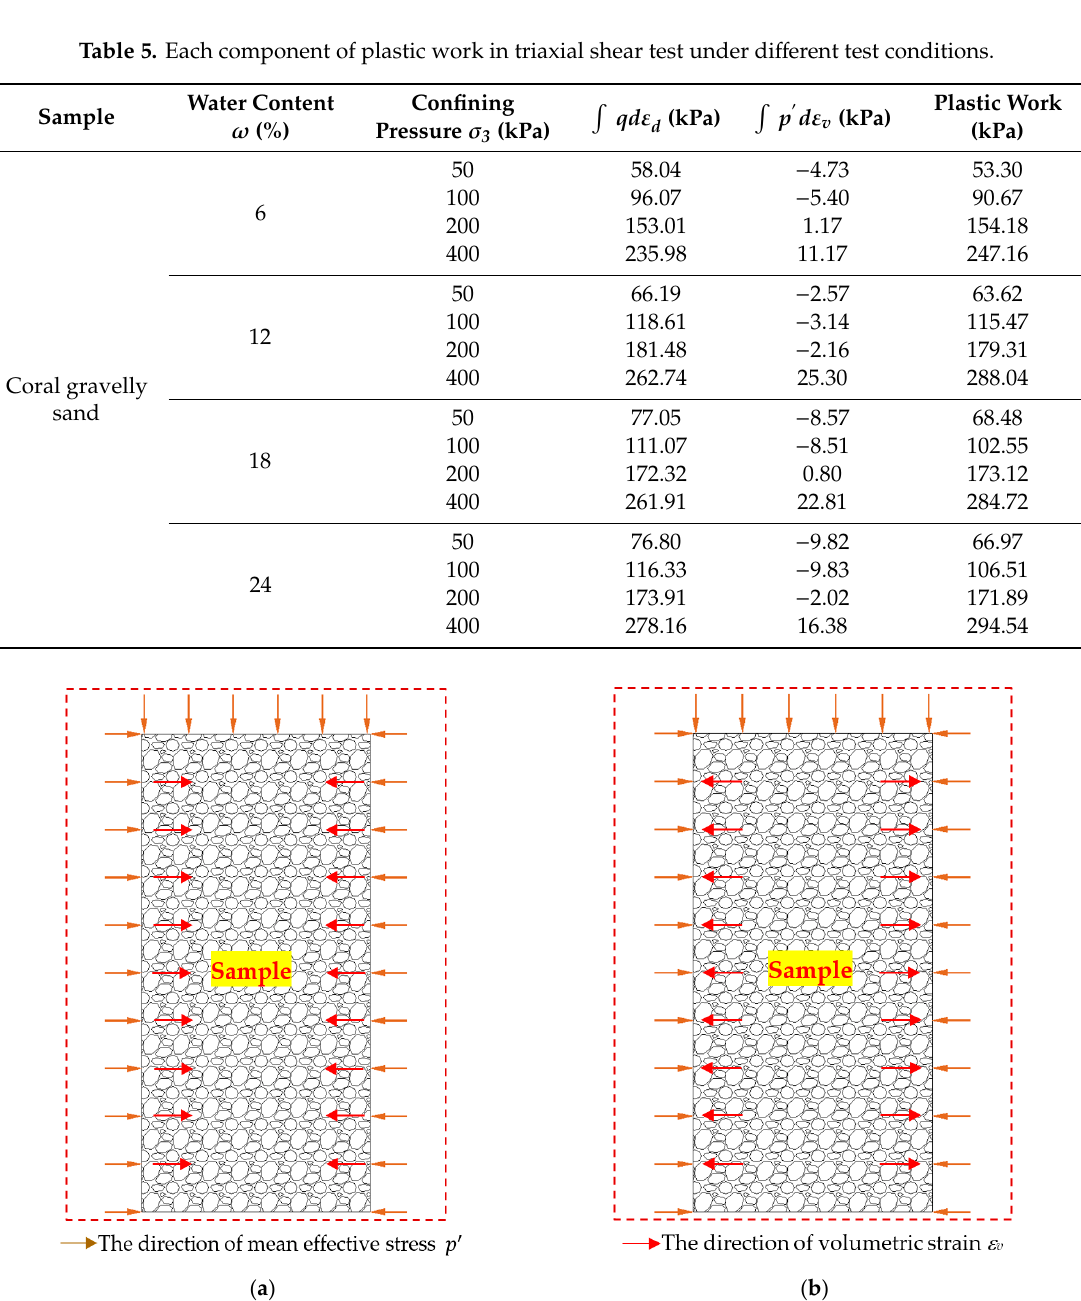
Figure 13. Schematic diagram of the directions of mean effective stress and volumetric strain under different deformation patterns: ( a ) Contraction, ( b ) dilatancy.